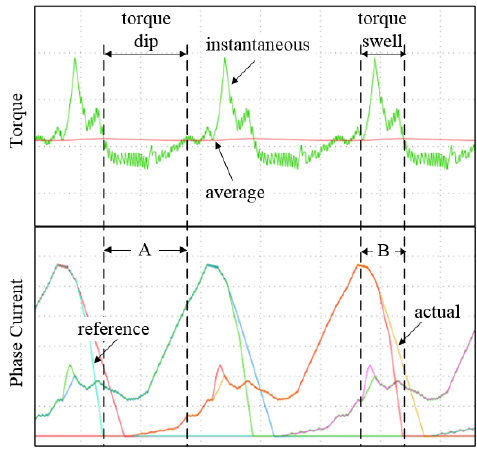
Figure 6. Waveforms of the produced torque and the phase current at the high speed of 1000